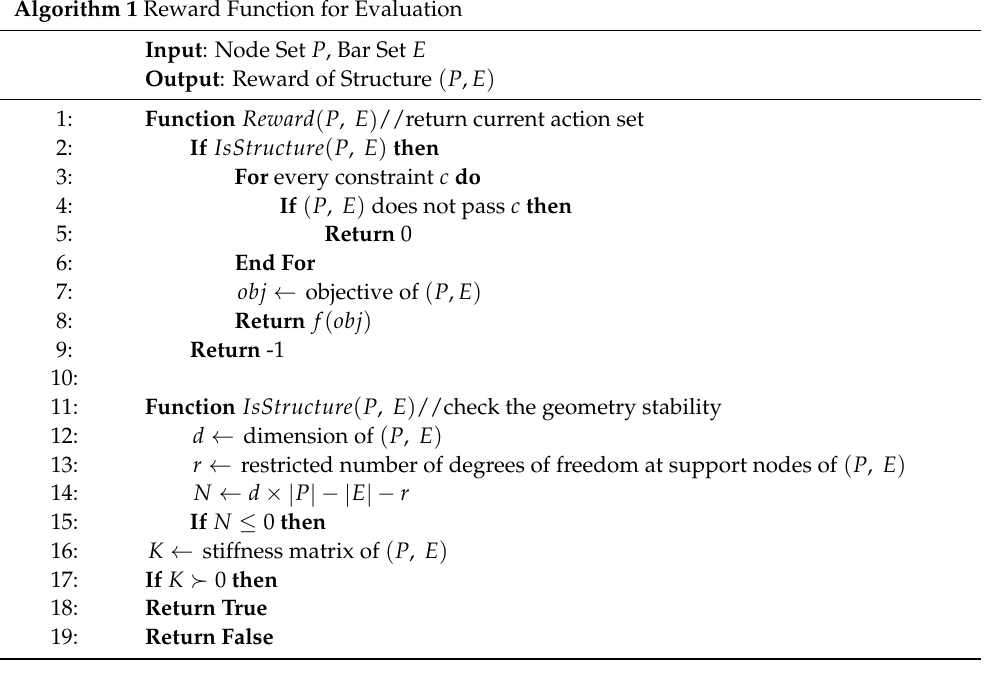
Algorithm 1 Reward Function for